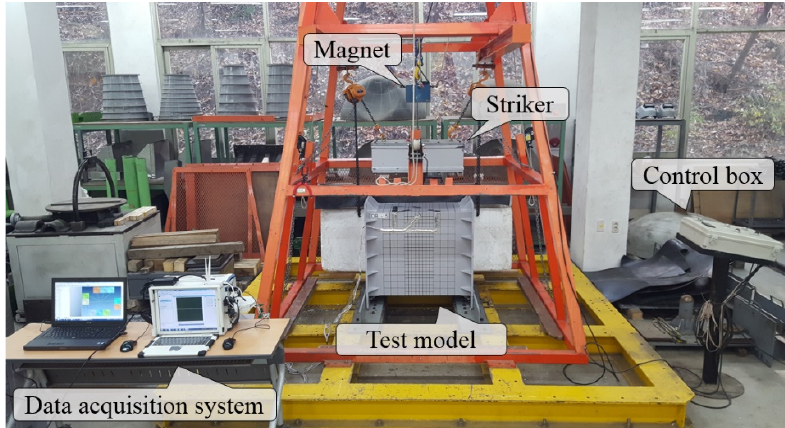
Figure 4. The experimental setup for the dynamic collision tests.